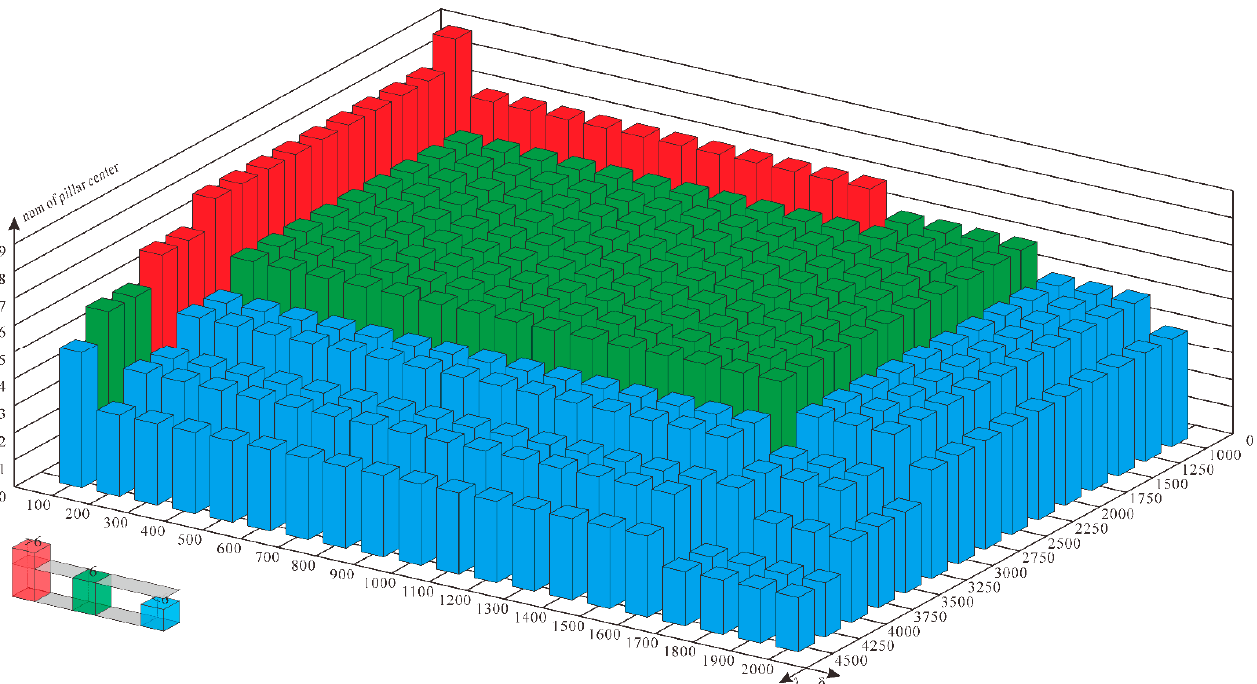
Figure 16. The relationship between the pillar center point extraction and the elimination threshold.